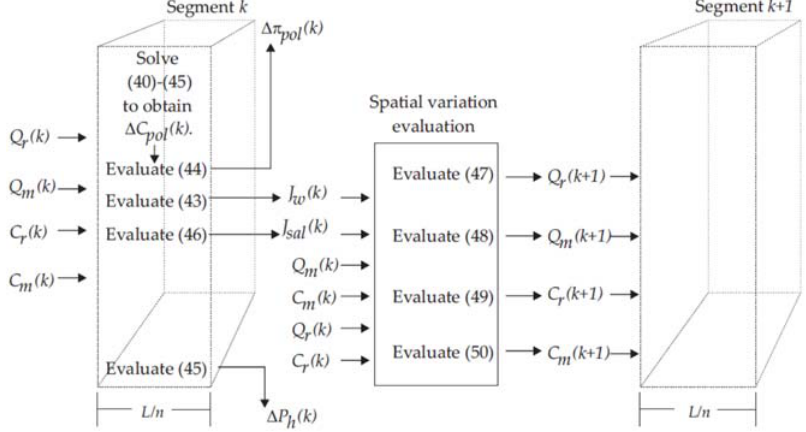
Figure 6. Consecutive segments for a single spatial variation step evaluation.